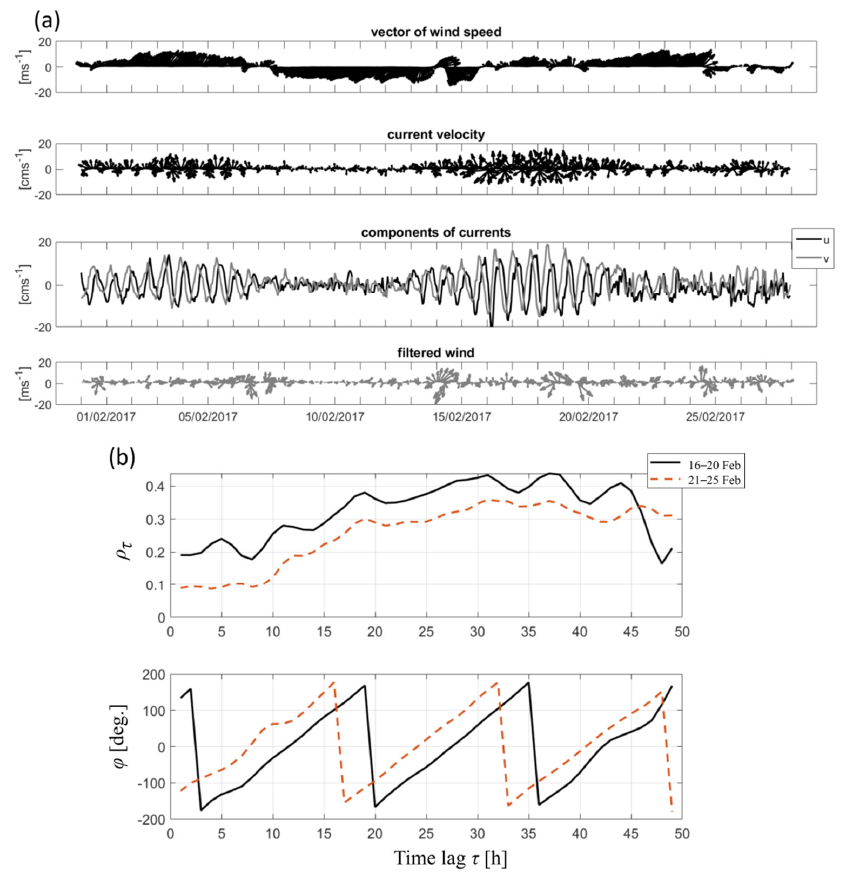
Figure 9. ( a ) Top—wind speed 𝐔(𝑡) vector plot from the ERA-5 meteorological reanalysis data. The second plot from the top is the current velocity 𝐮(𝑡) at 100 m at ABS No. 1 in February 2017, and the third plot from the top shows the 𝑢 - and 𝑣 -components of the current velocity. Bot- third plot from the top shows the u - and v -components of the current velocity. Bottom—wind speed tom—wind speed after band-pass filtering for 22–26 h. ( b ) Top—lagged correlations 𝜌 (cid:3099) between after band-pass filtering for 22–26 h. ( b ) Top—lagged correlations ρ τ between the wind and current the wind and current vectors for 16–20 and 21–25 February 2017, bottom—the angle 𝜑 of rotation vectors for 16–20 and 21–25 February 2017, bottom—the angle ϕ of rotation of the current velocity of the current velocity vector relative to the wind velocity vector. vector relative to the wind velocity